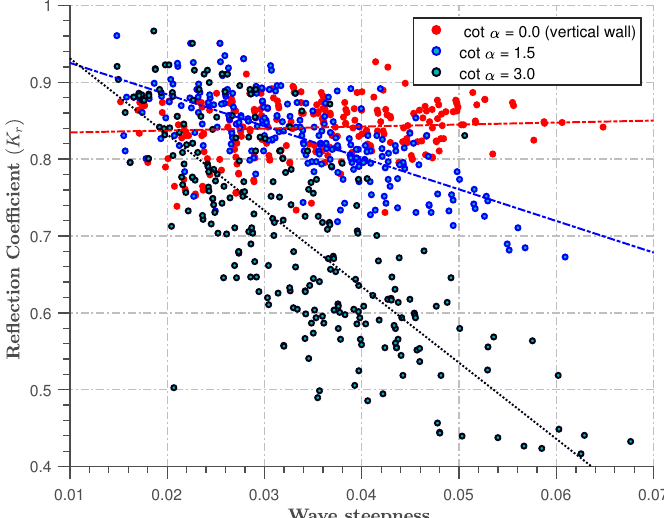
Figure 7. Relationships between wave steepness and the reflection coefficient K r across the three different slopes